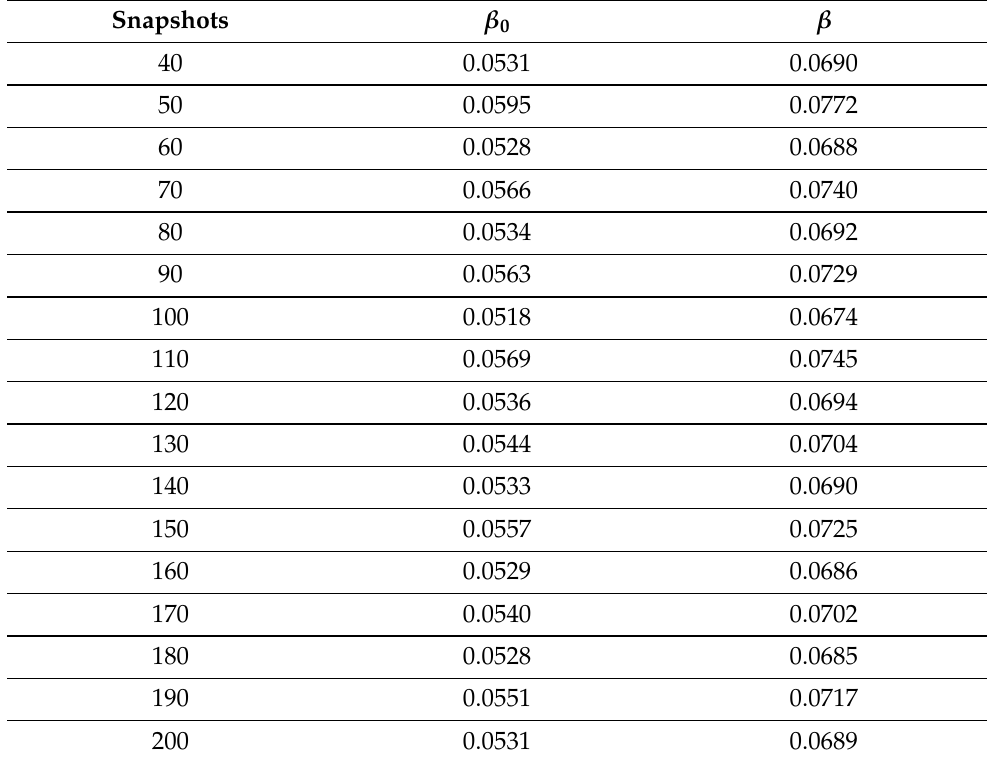
Table 6. Average β 0 and selected β value over 500 Trials with Respect to Number of Snapshots. SNR = 5 dB, Two emitters at 60 ◦ and 63 ◦